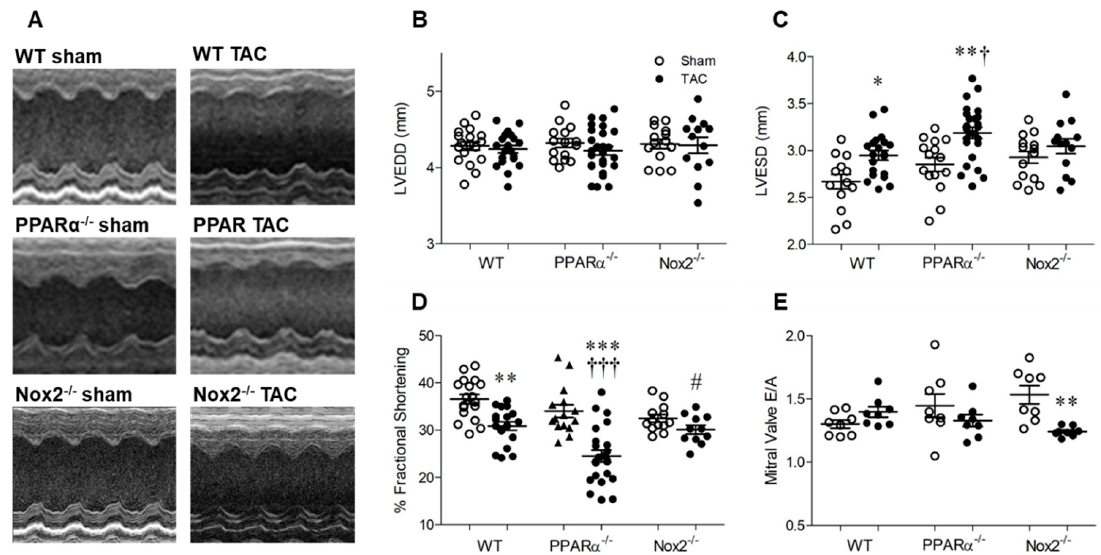
Figure 3. Pressure overload-associated cardiac dysfunction is Nox2 dependent and worsened in the absence of PPAR α . ( A ) Representative echocardiography M-mode images from WT, PPAR α − / − and Nox2 − / − mice subjected to TAC or sham operation. ( B ) Left ventricular end-diastolic diameter (LVEDD) is unchanged by pressure overload, whilst ( C ) left ventricular end-systolic diameter (LVESD) is increased by pressure overload in WT animals, an e ff ect which is amplified in the absence of PPAR α and prevented in the absence of Nox2. ( D ) Percentage fractional shortening is decreased by pressure overload in WT animals and further reduced in the absence of PPAR α and prevented in the absence of Nox2. ( E ) Mitral valve E / A ratio is decreased by pressure overload in the absence of Nox2 but unaltered in WT and PPAR α − / − animals. Mean ± SEM; N = 11–26; * p < 0.05, ** p < 0.01, *** p < 0.001 vs. corresponding sham, † p < 0.01, ††† p < 0.001 vs. corresponding WT, and # p < 0.05 vs. corresponding PPAR α .